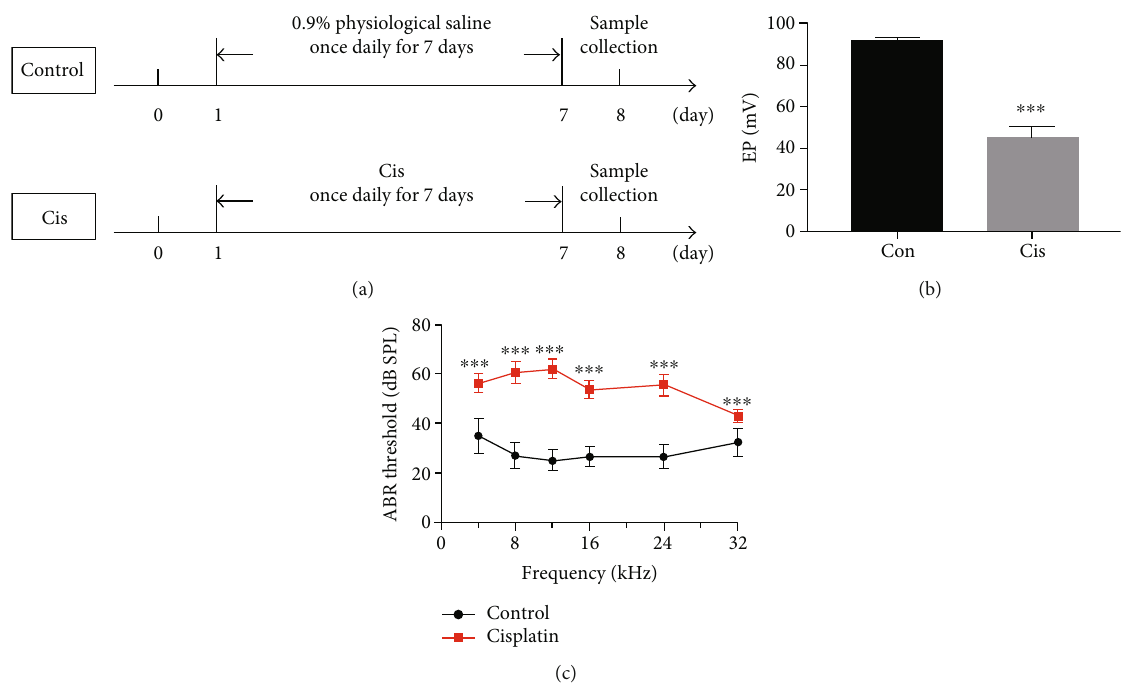
Figure 1: Cisplatin induced insult to auditory function. (a) C57BL/6 mice were divided into 2 groups and given i.p. injection of drugs as illustrated. (b) Endocochlear potentials were measured 7 days after cisplatin administration (3 mg/day/kg, i.p.). The EP in cisplatin-treated mice was signi fi cantly reduced compared to the control group ( n = 3 ). (c) ABR thresholds were measured at 4, 8, 12, 16, 24, and 48kHz in the control and cisplatin groups, and the ABR thresholds were elevated in the cisplatin group compared to the control group at all frequencies measured ( n = 18 ). Data are shown as mean ± SD . Cis: cisplatin; ∗∗∗ p < 0 : 001